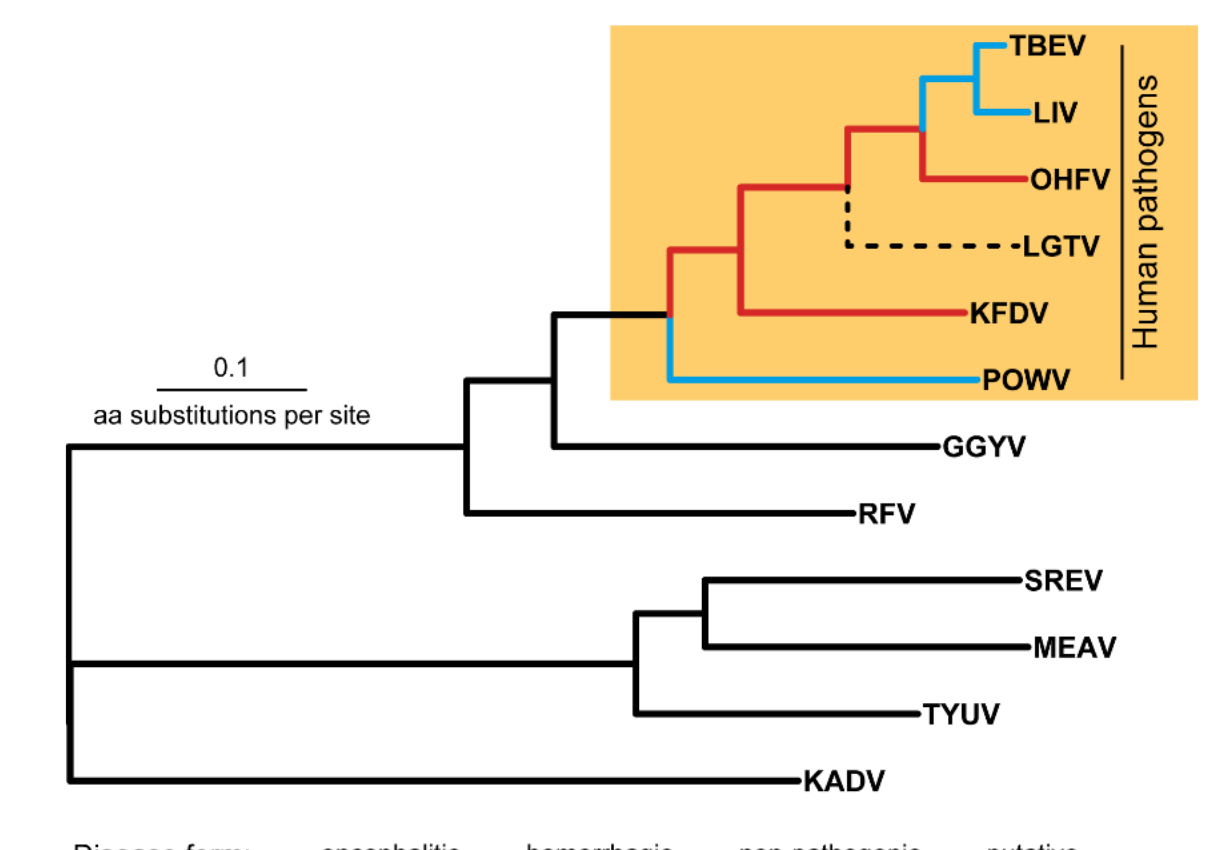
Figure 1. The tick-borne flavivirus species tree. Abbreviations: TBEV—tick-borne encephalitis virus, LIV—louping-ill virus, OHFV—Omsk hemorrhagic fever virus, KFDV—Kyasanur Forest disease virus KFDV, POWV—Powassan virus, GGYV—Gadgets Gully virus, RFV—Royal Farm virus, SREV—Saumarez Reef virus, MEAV—Meaban virus, TYUV—Tyuleniy virus, KADV—Kadam vi- rus.